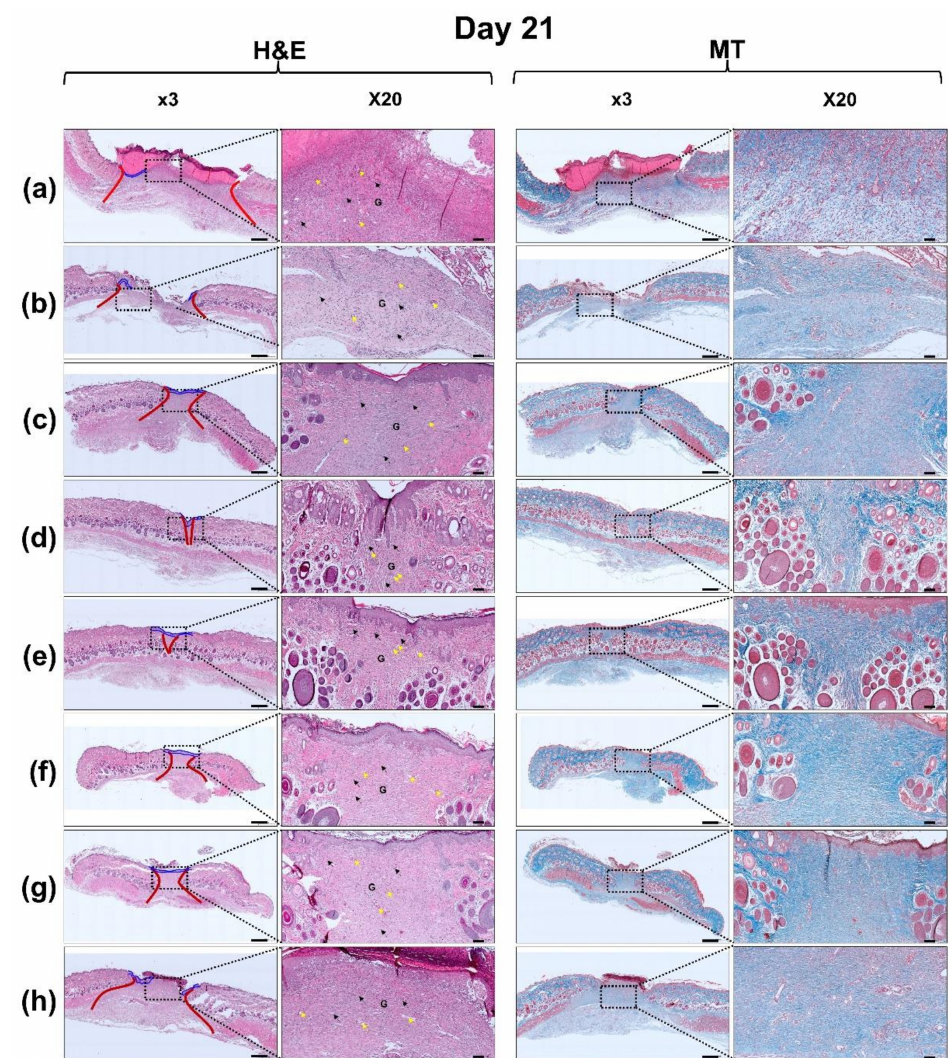
Figure 12. H&E and MT stained slides of wounds treated with ( a ) 2-GHC-FD-8; ( b ) 2-GHC-FD-8/F1; ( c ) 2-GHC-FD-8/F2, ( d ) 2-GHC-FD-8/F3; ( e ) 2-GHC-FD-8/F4; ( f ) 2-GHC-FD-8/F5; ( g ) 2-GHC-FD- 8/F6; and ( h ) 2-GHC-FD-8/F7 for 7, 14, and 21 days. At slides at × 3, red and blue lines indicate boundary between normal and newly formed tissues, and newly formed epithelial layer, respectively. At slides at × 20, black and yellow arrows indicate inflammatory cells and newly formed blood vessels, respectively. G: granulation